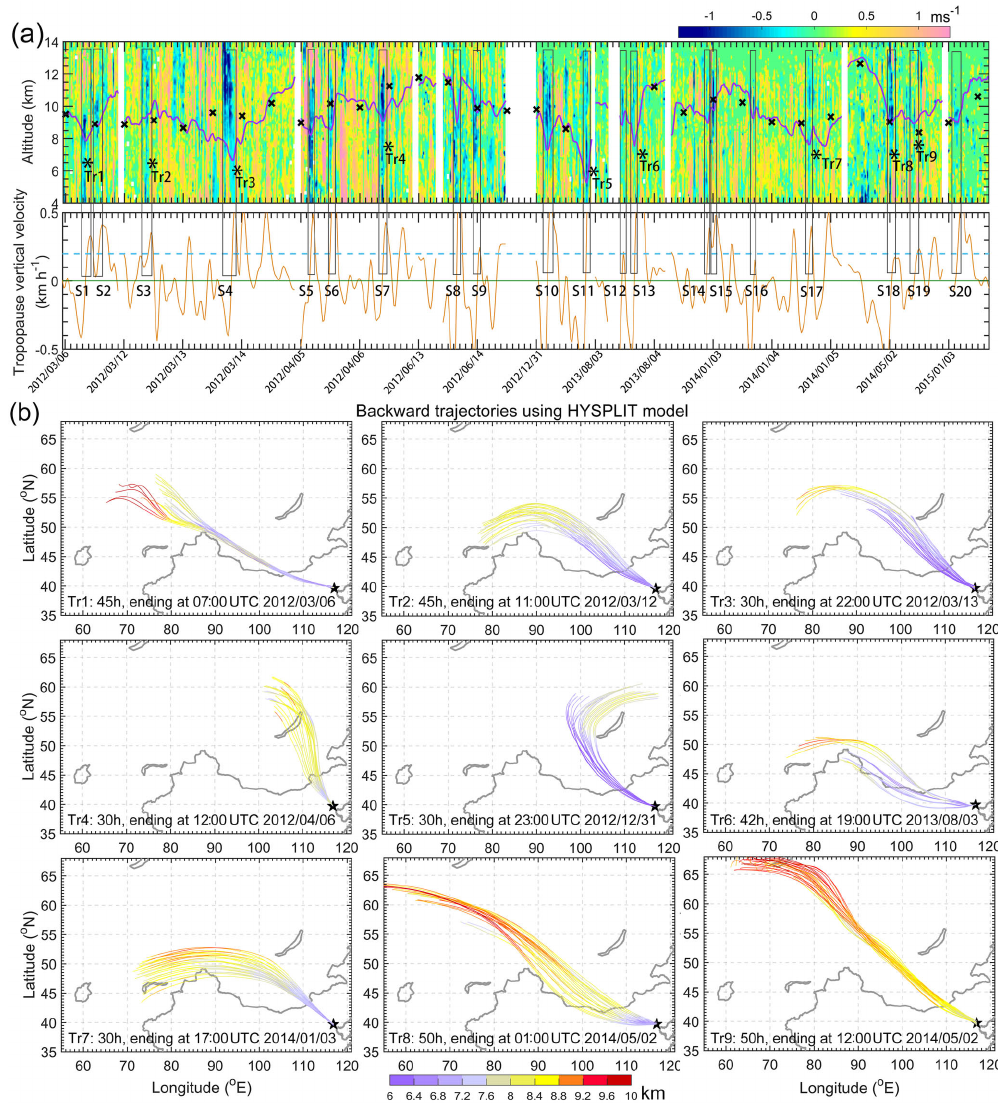
Figure 11. (a) Height–time section of several episodic observations of the radar-derived vertical wind (colors in ms − 1 ) along with RT height (purple bold line) and LRT height (bold crosses), between March 2012 and January 2015. The corresponding vertical velocity of the RT (orange line) is plotted in the lower panel of (a) ; the dotted blue line indicates the value of 0.2kmh − 1 . Dates for the observations are displayed as year/month/day. Black rectangular boxes represent the cases of strong downdraughts (absolute value ≥ 0 . 5ms − 1 ) preceding rapid tropopause ascent (>0.1kmh − 1 ) and are labeled as S1, S2, S3, ..., S20. The symbol “ ∗ ”, labeled Tr1–Tr9, indicates the ending point of the corresponding trajectories in Fig. 12b. (b) Results of backward trajectories (colors in km) of the nine typical selected cases from Fig. 12a, providing the signature and source of possible stratospheric